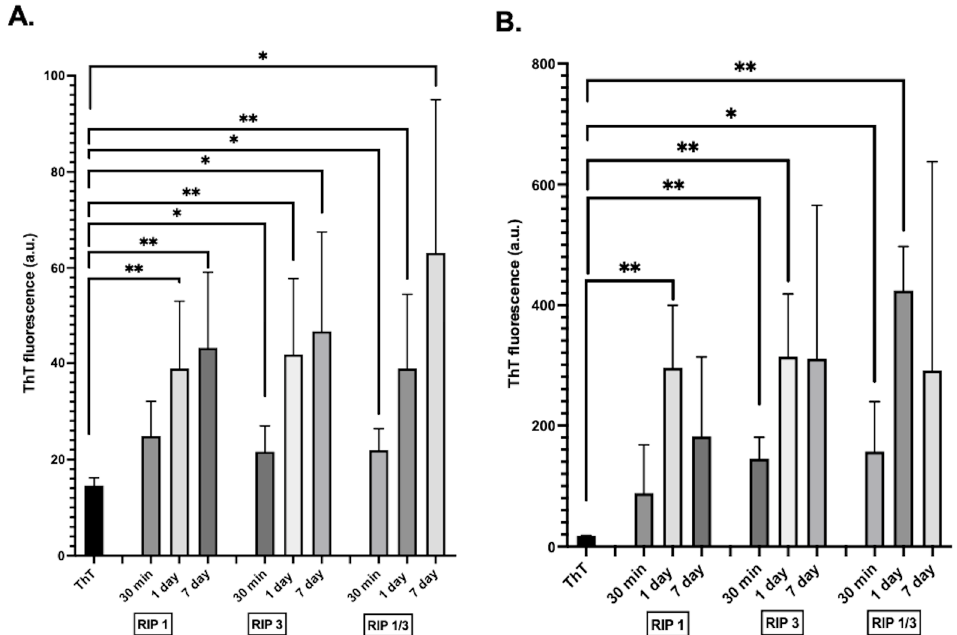
Figure 3. Effect of concentration on 12 amino acid RHIM fragments RIP1, RIP3, and RIP1/RIP3 aggregation. ( A ). ThT fluorescence of 100 µM peptides aggregation. ( B ) ThT fluorescence of 1 mM peptides aggregation. n = 3 ± SEM, * p < 0.05, ** p < 0.01.